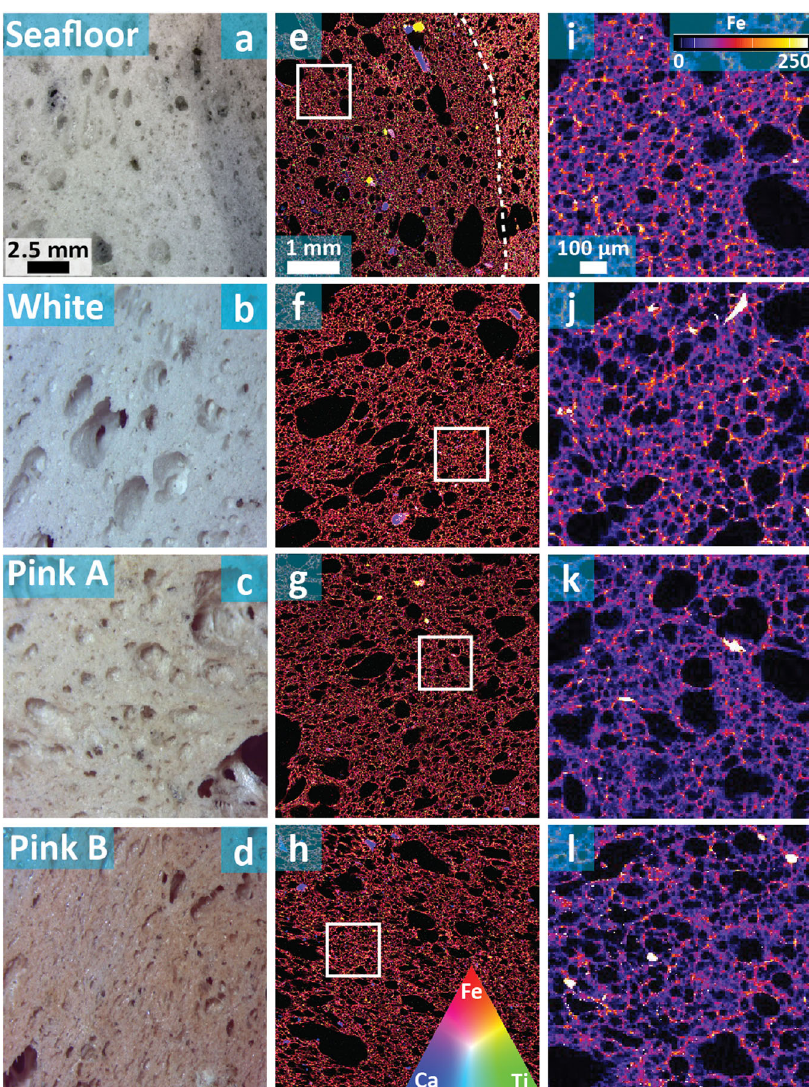
Fig. 1 Characteristics of the main pumice types from the 2012 Havre eruption. a – d Stereoscope images showing the representative colours and textures of the 4 pumice types analysed in this study; white and pink refer to pumice raft material. Note the grey and white pumice bands in the sea fl oor pumice. e – h XFM-Fe, Ti, Ca-RGB stacked elemental maps for the different pumice types. Boundary between white and grey pumice domains for the sea fl oor pumice indicated by white dashed line in ( e ). XFM elemental maps are colour-coded based on a RGB triangle where red, green and blue are end members correlating to high Fe, Ti and Ca, respectively. Where multiple elements are co-located, the pixel displays a colour that represents the relative proportion of each element ’ s concentration. For example, Fe – Ti oxides will appear yellow, orthopyroxene crystals will appear pink and plagioclase crystals blue. i – l Corresponding XFM Fe elemental maps for the areas outlined by white boxes in ( e – h ). Fe elemental maps are set to a fi re colour scale ( µ g*cm − 2 ) where white pixels correlate to areas of high Fe-intensity, indicating Fe – Ti oxide microlites. Yellow pixels represent either orthopyroxene microlites or Fe – Ti nanolite glass mixtures. Scale bars in top row ( a , e , i ) applies to the entire column below (e.g., a , b , c , d are in the same scale as presented in ( a